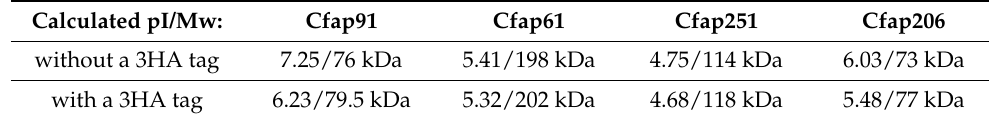
Table 3. Calculated theoretical pI and Mw of analyzed proteins.